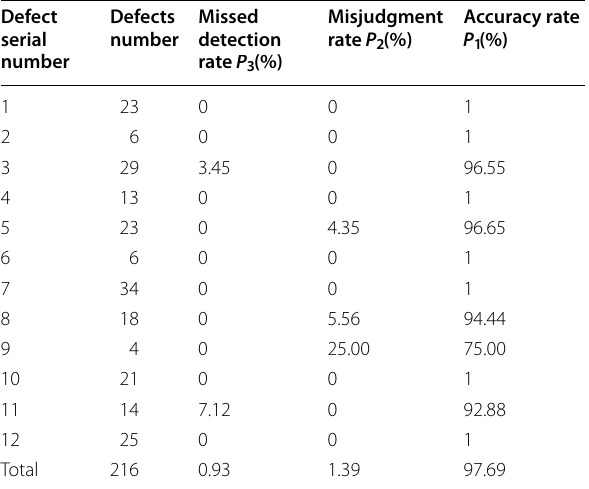
Table 4 Type II railway track ultrasound image test